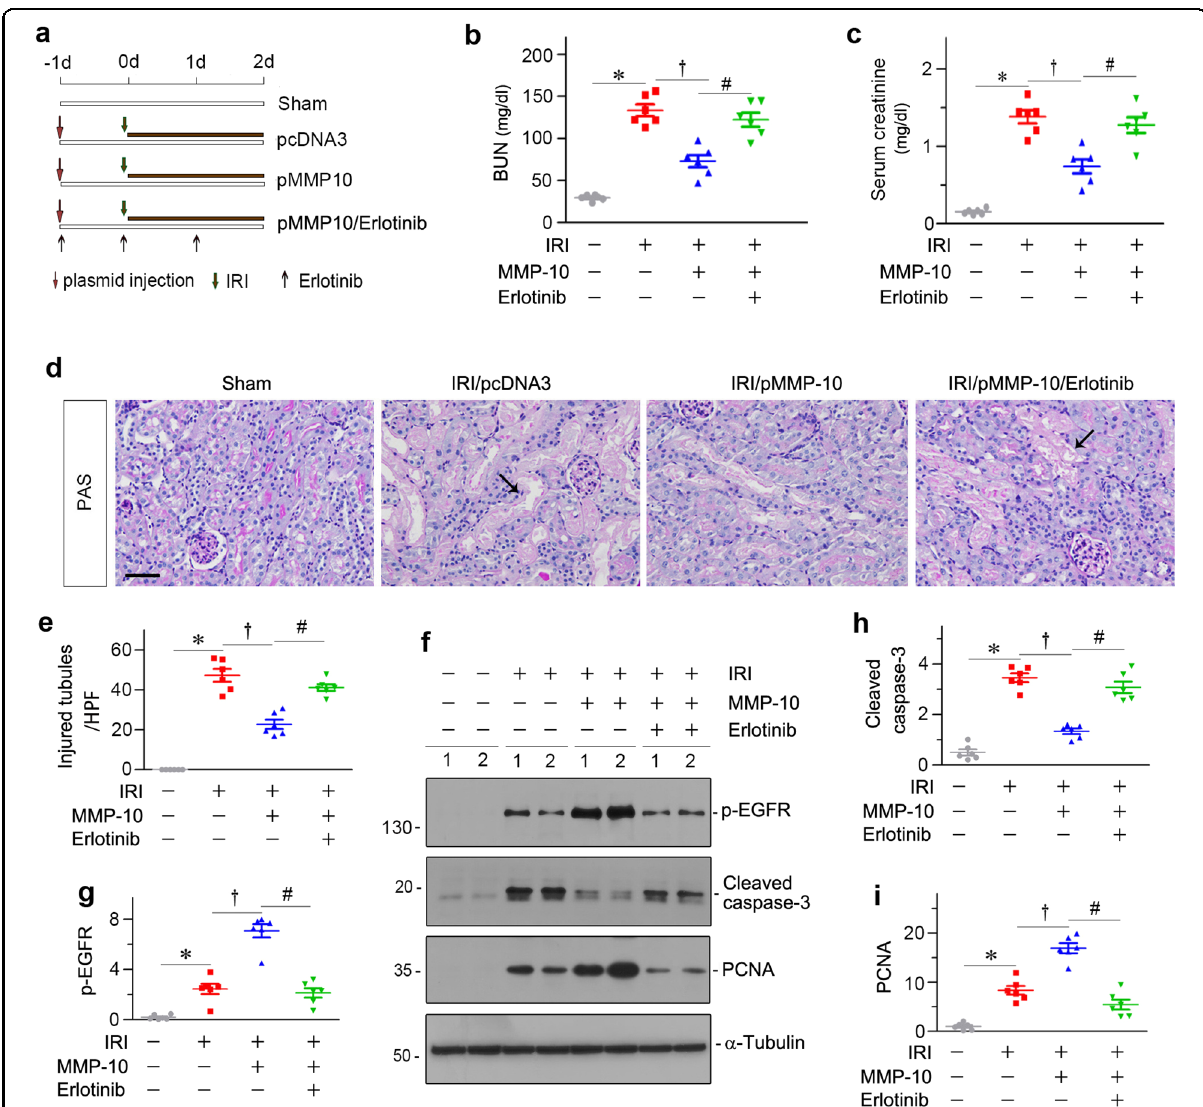
Fig. 6 Pharmacologic inhibition of EGFR signaling abolishes the protective role of exogenous MMP-10 after IRI. a Experimental design. Red arrows indicate the injection of plasmids. Green arrows indicate the timing of IRI surgery. Black arrows indicate the oral gavage of erlotinib. b , c Graphic presentations show blood urea nitrogen (BUN) ( b ) and serum creatinine ( c ) levels in different groups as indicated. * P < 0.05 versus sham controls ( n = 6); † P < 0.05 versus IRI injected with pcDNA3 ( n = 6). # P < 0.05 versus IRI injected with pMMP-10 ( n = 6). d Representative micrographs show kidney morphology at 2 days after IRI in different groups as indicated. Arrows indicate injured tubules. Scale bar, 50 µm. e Quantitative determination of injured tubules in different groups is shown. Kidney sections were subjected to PAS staining. At least 10 randomly selected high- power fi elds were evaluated and results averaged for each kidney. * P < 0.05 versus sham controls ( n = 6); † P < 0.05 versus IRI injected with pcDNA3 ( n = 6); # P < 0.05 versus IRI injected with pMMP-10 ( n = 6). f Representative western blots show renal expression of p-EGFR, cleaved caspase-3 and PCNA in different groups as indicated. Numbers (1 and 2) indicate each individual animal in a given group. g – i Graphic presentations show the relative abundances of renal p-EGFR ( g ), cleaved caspase-3 ( h ), and PCNA ( i ) proteins in different groups as indicated. * P < 0.05 versus sham controls ( n = 6); † P < 0.05 versus IRI injected with pcDNA3 ( n = 6); # P < 0.05 versus IRI injected with pMMP-10 ( n =